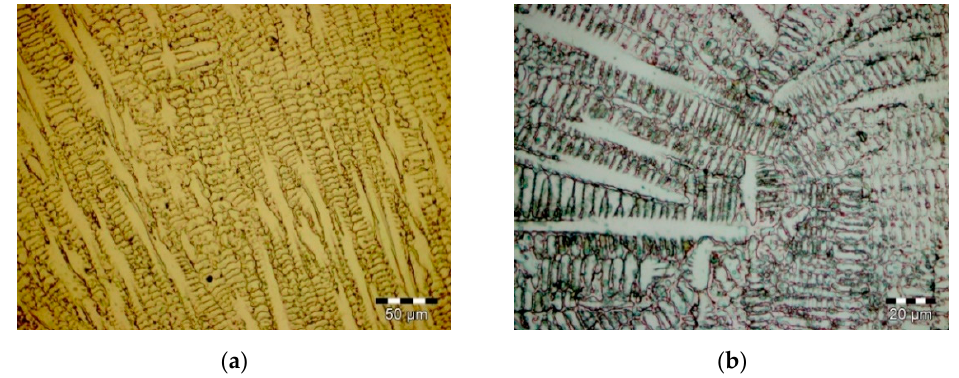
Figure 2. Microstructure of the CoCrWNi alloy: ( a ) sample lateral area; ( b ) detail of the sample central area.